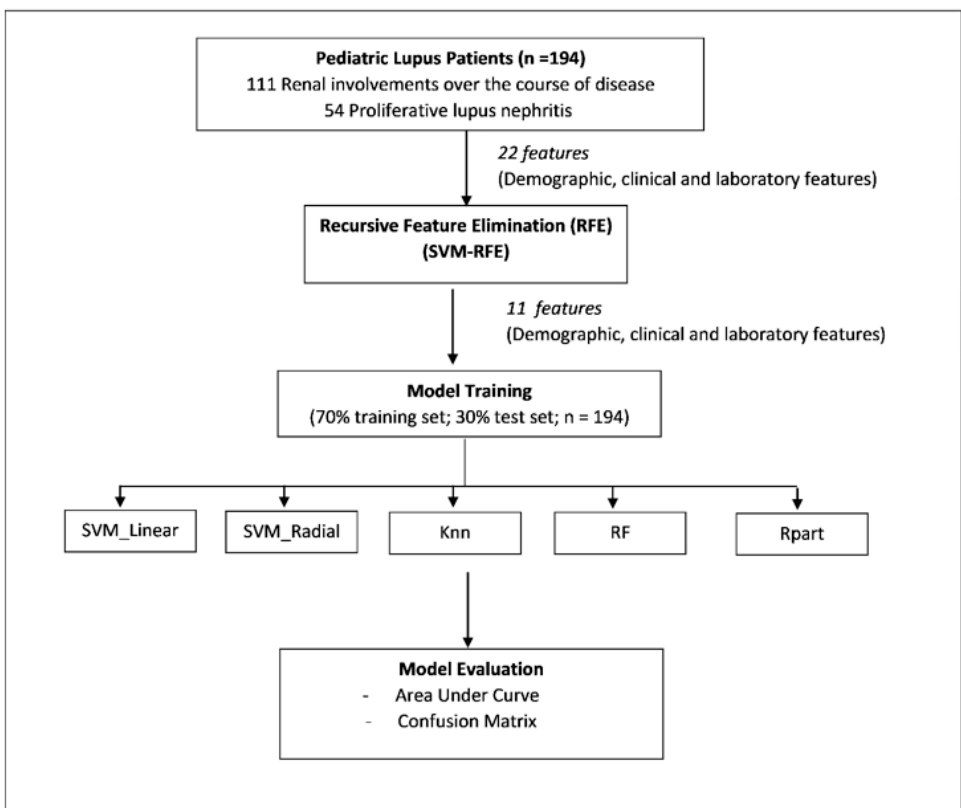
Figure 1. Workflow process for feature selection, model training and evaluation. SVM-RFE: Support vector machine classification- Recursive Feature Elimination; SVM_Linear: Support vector machine with linear kernel; SVM_Radial: Support vector machine with radial kernel; Knn: K nearest neighbors; RF: random forest; Rpart: decision-tree Rpart.